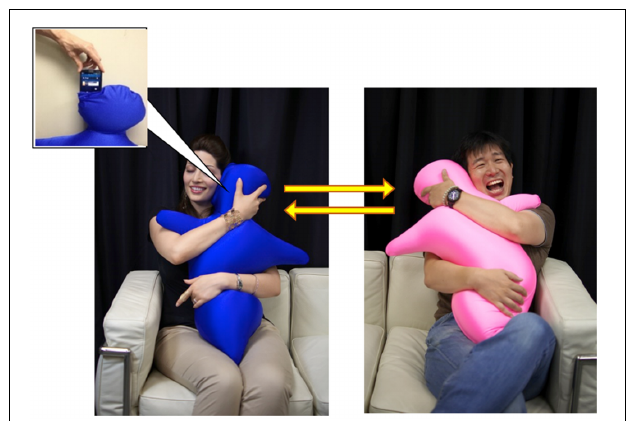
FIGURE 1 | Hugvie (huggable communication